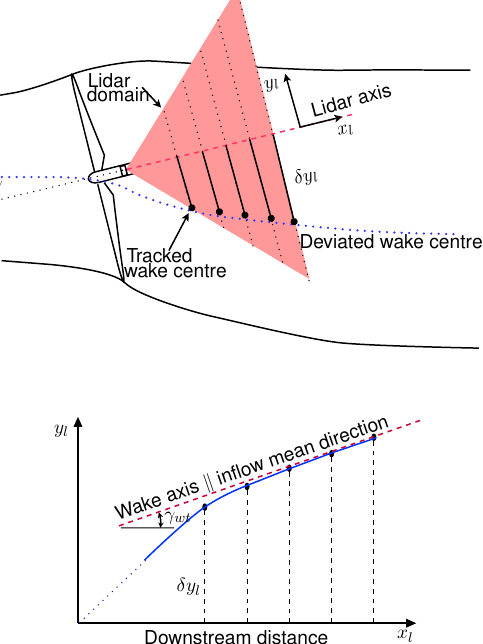
Figure 1. Sketch of near-wake path reconstruction. Top panel: top view of lidar wake tracking. Shadowed area shows the area which is covered by a lidar system aligned with the rotor axis. Perpen- dicular dotted lines represent one-dimensional or two-dimensional scans parallel to the rotor. Dots depict estimated wake centres. Bot- tom panel: reconstruction of near-wake path and estimation of yaw misalignment based on discrete measurements. Lidar frame of ref- erence (subscript “l”) assumed perfectly aligned with the nacelle